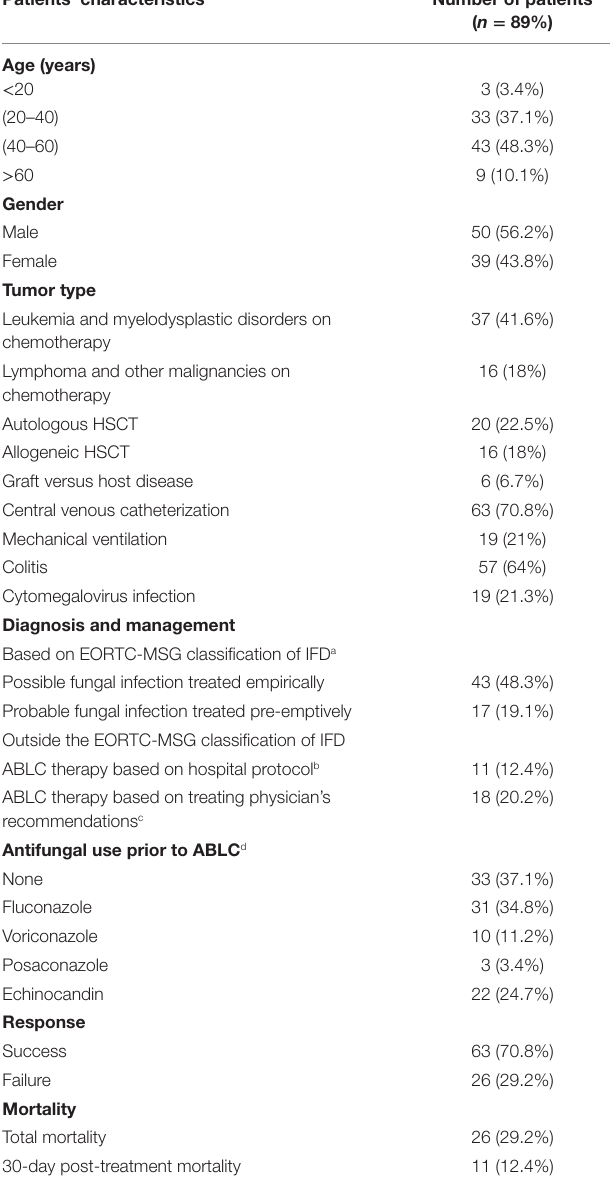
outcome of patients receiving amphotericin B lipid complex therapy. Patients’